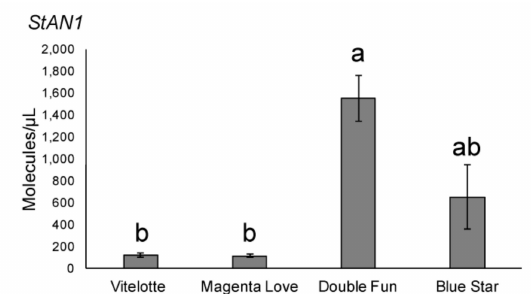
Figure 4. Comparative genetic profiling of pigmented potato cultivars. Gene expression analysis in tubers of potato genotypes as monitored by absolute Real-Time Quantitative Reverse Transcription PCR (qRT-PCR). Each value represents the mean of three determinations ( SD). Means denoted by the same letter did not di ff er significantly at p 0.05 according to Tukey’s test.